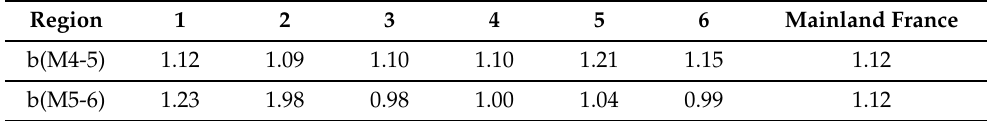
Table 4. b-values computed by regressing GR law (Equation (10)) for different ranges of magnitudes on synthetic FMD of main shocks (Figure 10) obtained in each SHARE region. Region numbers refer to Figure